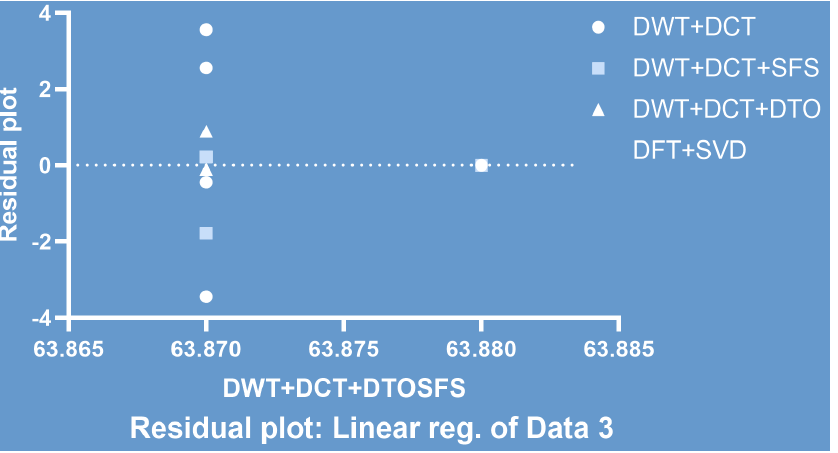
Figure 8. The residual plot of the competing approaches compared to the proposed DWT+